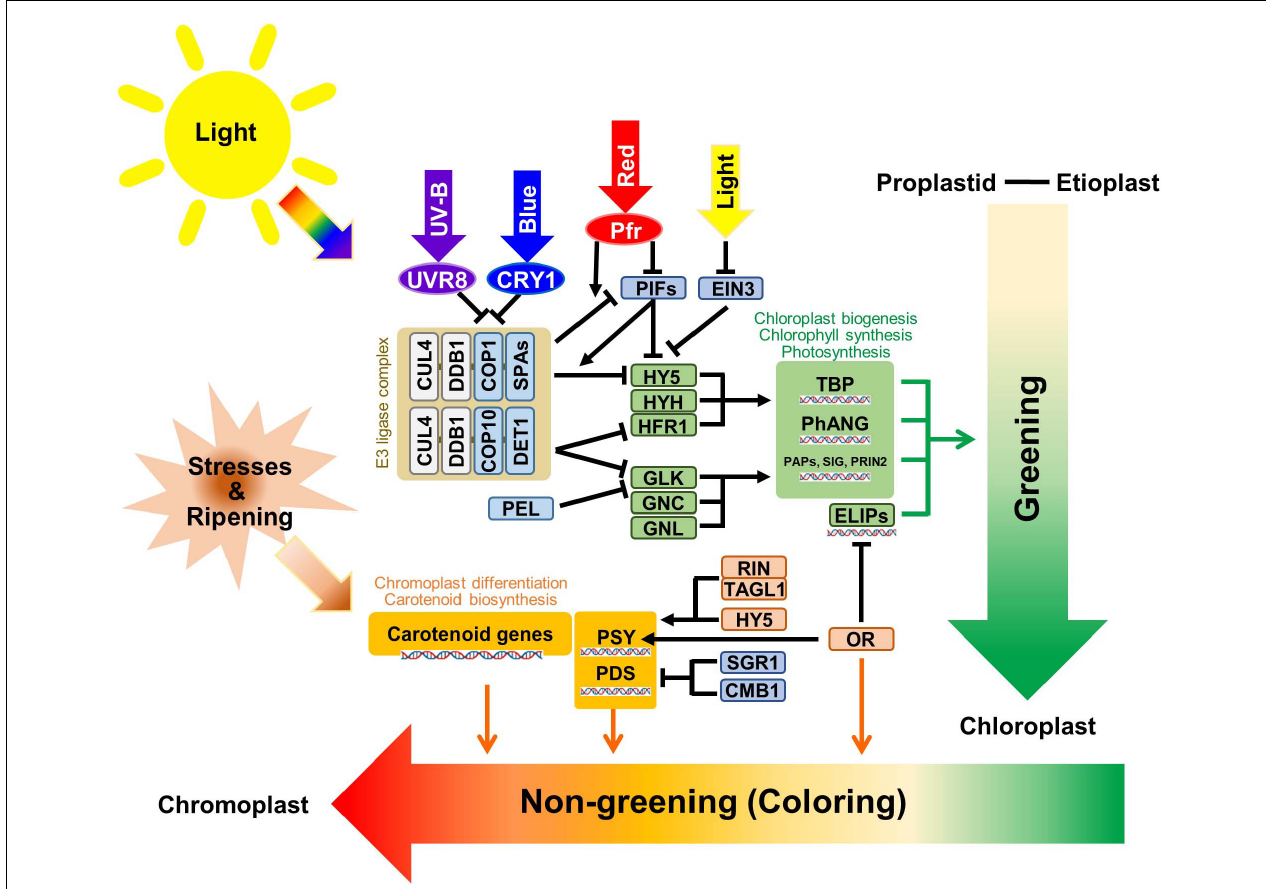
FIGURE 2 | Schematic diagram of the plastid transition regulations. The regulatory mechanisms of greening and non-greening plastid interconversions are briefly summarized with core transcriptional and post-translational regulators. The light signals from different wavelengths are indicated with thick arrows with representative colors. The photoreceptors are shown with circles, while regulatory genes are shown within rectangular boxes. E3 ligase complexes, chloroplast biogenesis related enzymes, and chromoplast biogenesis related enzymes were categorized with white brown, green, and orange-colored boxes, respectively. DNA helix symbols represent the transcriptional regulation of genes. Green lines indicate the direct effects of “Greening” while red lines indicate the direct effects of